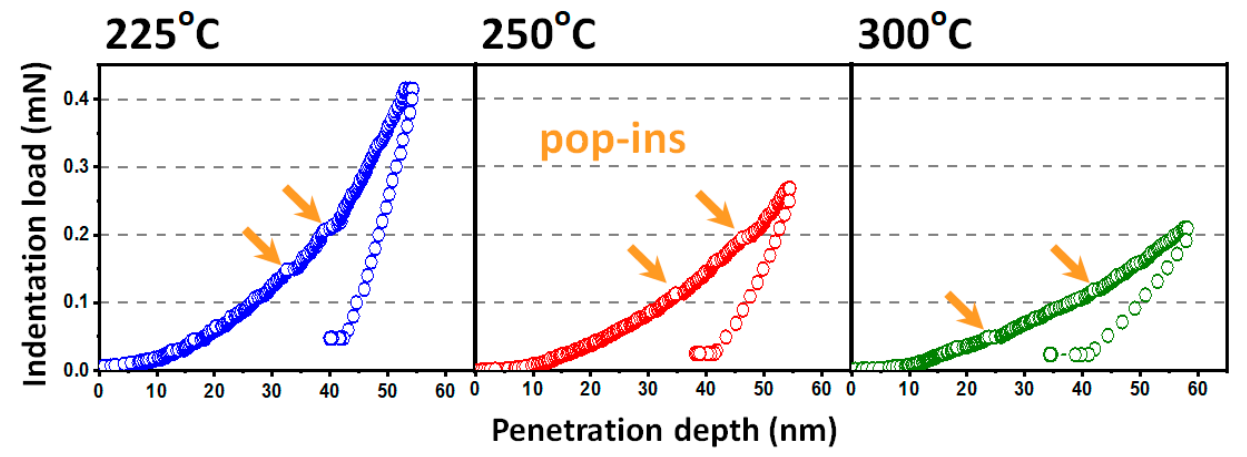
Figure 4. CSM nanoindentation Ph -curves of the Bi 2 Te 3 thin films deposited on the c -plane sapphire substrates at the various T S from 225 to 300 °C.